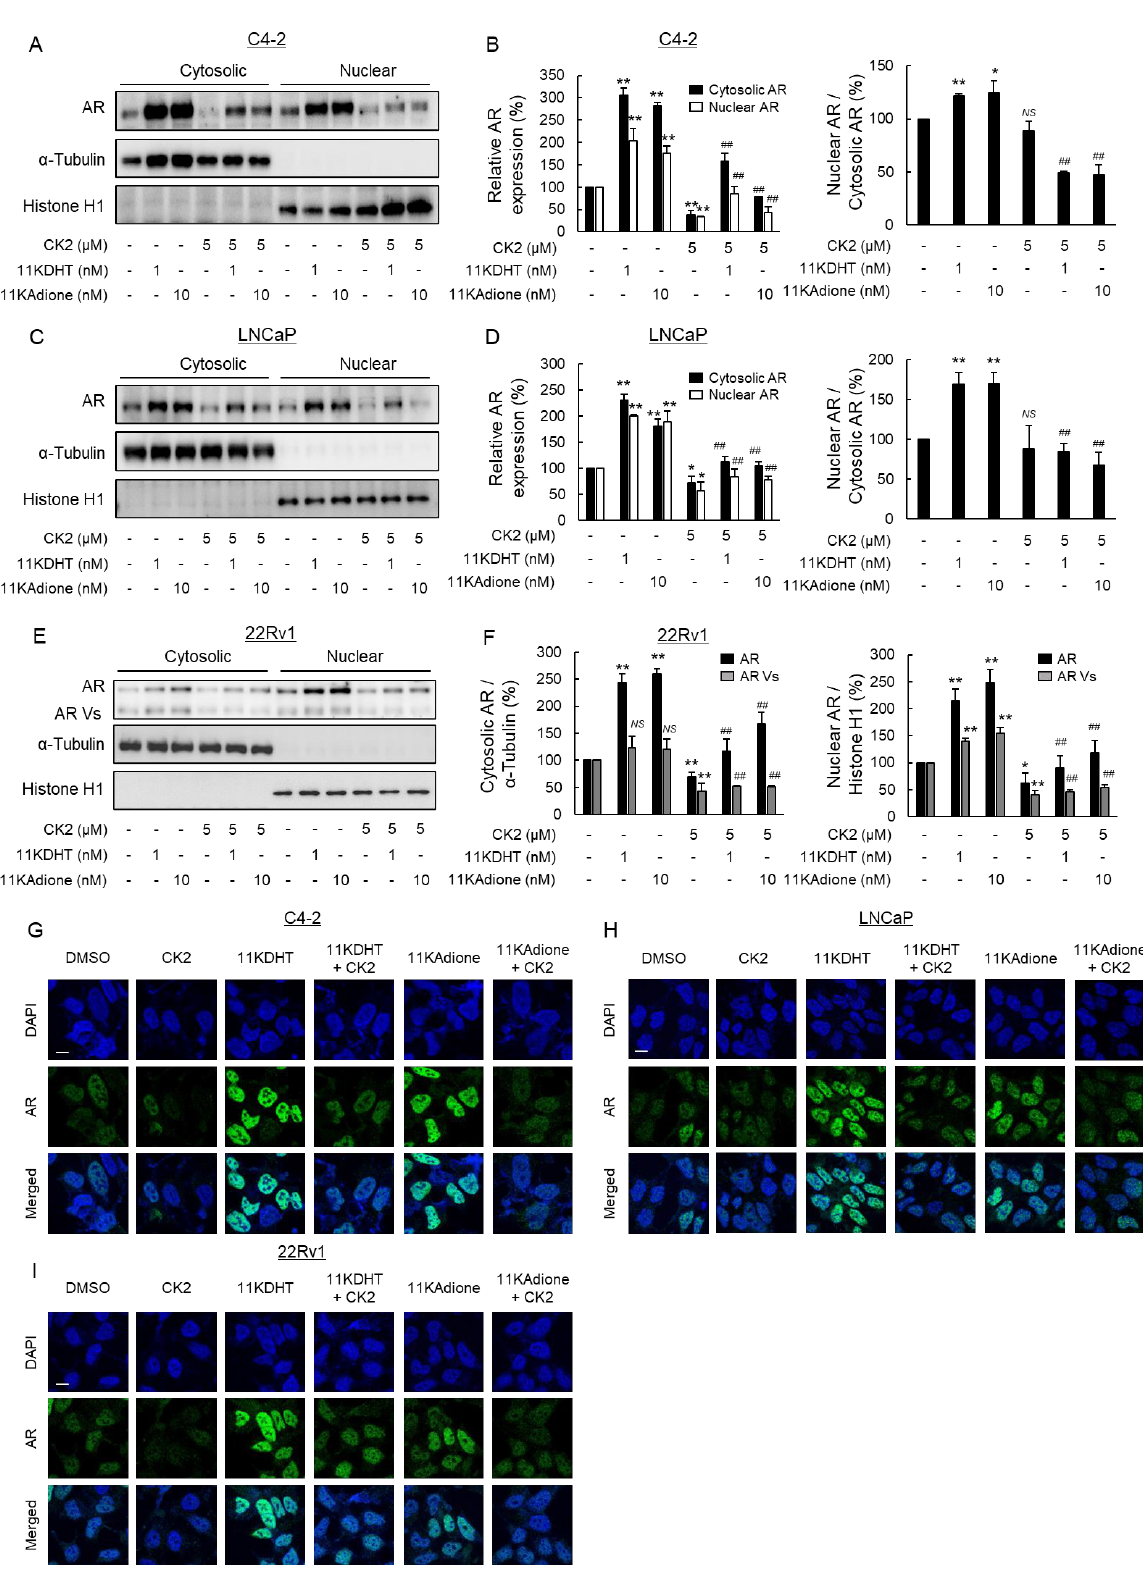
Figure 7. Effects of KC-A on 11-ketoandrogen-induced AR signaling in C4-2, LNCaP and 22Rv1 cells. The cells were pretreated for 2 h without or with 5 µ M KC-A, and then cultured for 24 h in the absence or presence of 1 nM 11KDHT or 10 nM 11KAdione in the cells. ( A – F ) Nuclear expression of AR and AR Vs. The nuclei of the cells were fractionated from the cytosol by using a LysoPure Nu- clear and Cytoplasmic Extractor Kit and analyzed by immunoblotting. The protein levels are ex- pressed as a percentage of the band density relative to those in the control cells treated with DMSO alone. ** p < 0.01, * p < 0.05, NS p > 0.05 denotes significantly different from the cells treated with DMSO alone. ## p < 0.01 denotes significantly different from the cells treated with 1 nM 11KDHT or 10 nM 11KAdione alone. ( G – I ) Immunofluorescence staining. The C4-2 ( G ), LNCaP ( H ) and 22Rv1 ( I ) cells were stained with the anti-AR antibody (green) and DAPI (blue). Merged images are also shown. Scale bar indicates 10 μm.